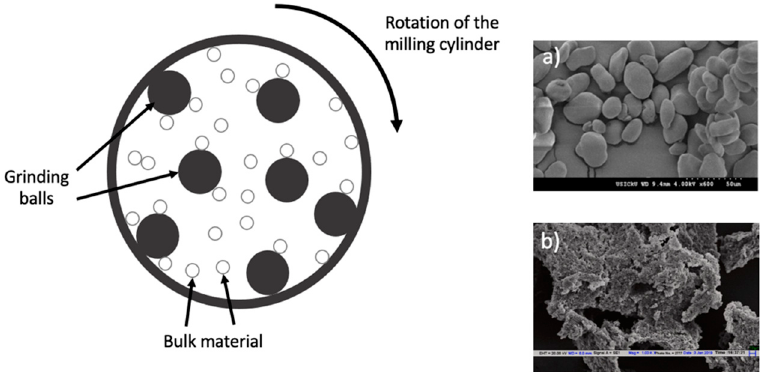
Figure 7. Synthesis of SNPs through ball milling method and SEM micrographs of ( a ) water chestnut SNPs [53] (reprinted with permission from Elsevier. Copyright (2019)) and ( b ) lotus stem, horse and water chestnut [54] (reprinted with permission from Elsevier. Copyright (2021)).